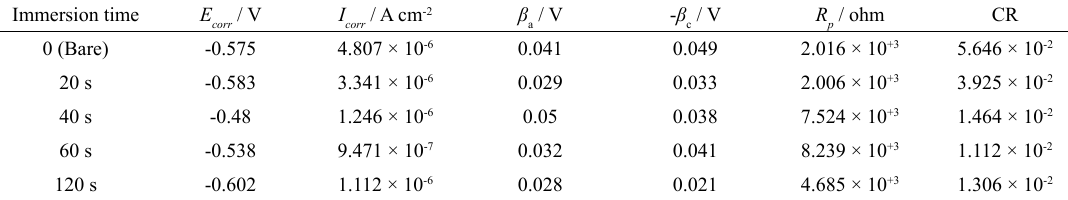
Table 1. Potentiodynamic polarization parameters of different immersion times for the cerium coatings in 3.5 wt. % NaCl solution. Coatings were prepared by immersion in cerium solution in 25 °C. Immersion time